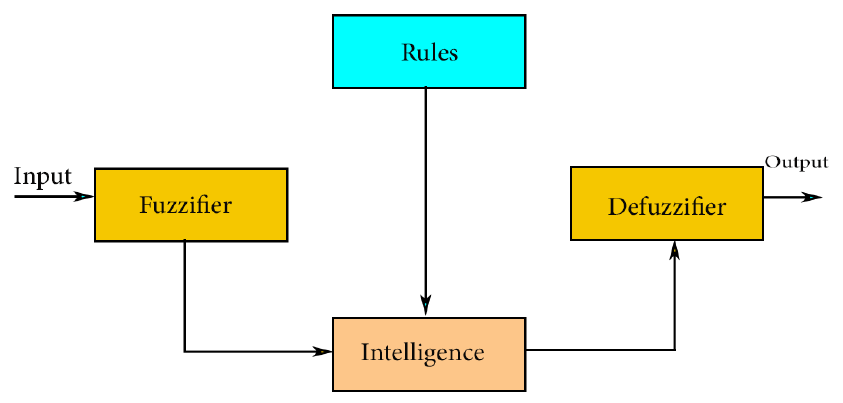
Figure 6. The architecture of fuzzy